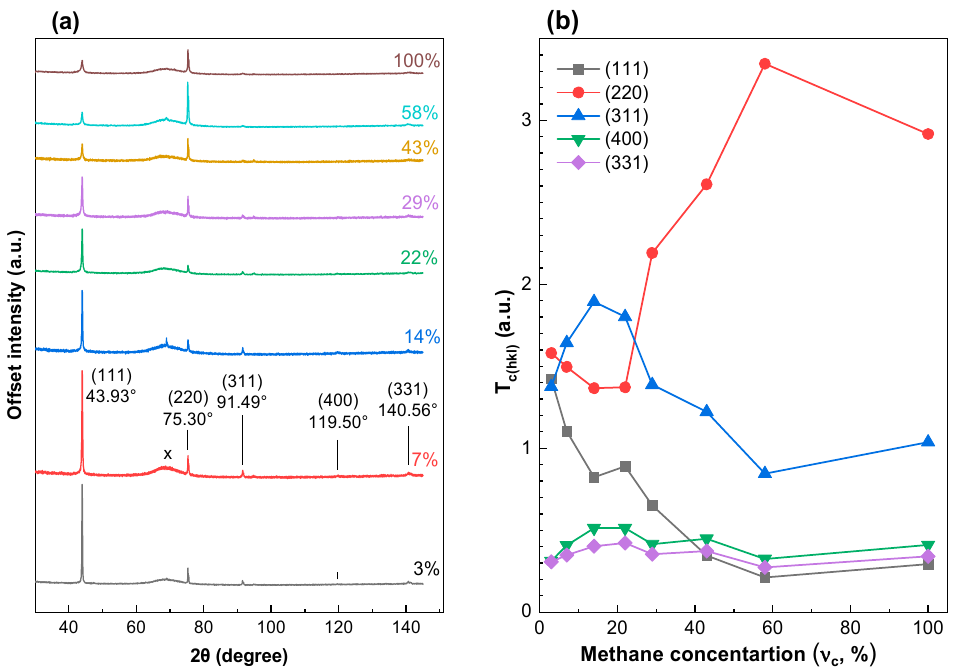
Figure 3. XRD patterns ( a ) and variation in texture coefficient T c ( b ) for the polycrystalline diamond films synthesized at substrate temperatures T s = 900 ± 25 ◦ C and different ν c . A wide set of peaks in region 2 θ ~69 ◦ belongs to the decomposition of the X-ray tube spectrum on Si (100) substrate. The values of the texture coefficient T were calculated. The effect of methane concentration on the texture coefficients T along the (111), (220), (311), (400) and (331) planes is shown in Figure 3b. At standard methane concentration 𝜈 (cid:3030) = 3% (111), (220) and (311) planes have the same 𝑇 (cid:3030)((cid:3035)(cid:3038)(cid:3039)(cid:4667) value, which is higher than (400) and (331). With an increase in 𝜈 (cid:3030) up to 22%, a sharp decrease in 𝑇 (cid:3030)((cid:2869)(cid:2869)(cid:2869)(cid:4667) is observed. Note the simul- taneous change in the film structure at the same concentration (Figure 3). With a further increase in 𝜈 𝑐 , an increase in the reflection (220) is observed due to a further decrease in the reflection (111). Thus, films obtained at an ultrahigh methane concentration have a 220 texture. 3.3. Growth Rates It is well known that the growth rate of diamond increases with the substrate tem- perature. We confirm an almost linear increase in the growth rate from 0.8 to 4.6 µm/h with T (cid:2929) elevation for the films deposited at 𝜈 (cid:3030) = 40% (Figure 4a).